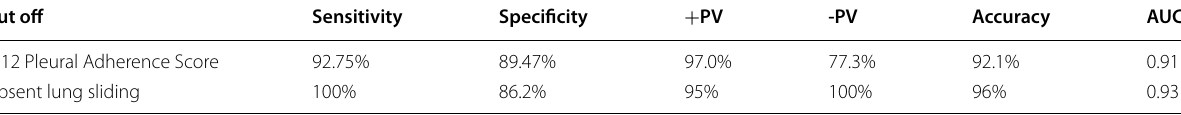
Table 8 Diagnostic performance of Pleural Adherence Score and absent lung sliding for predicting successful pleurodesis Cut